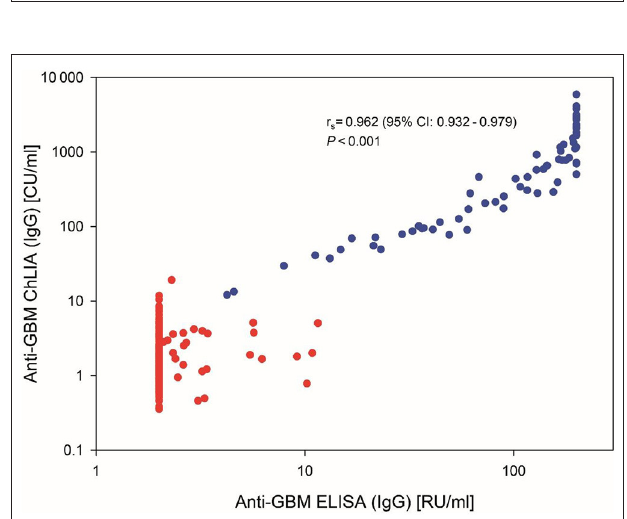
FIGURE 2 | Correlation between anti-GBM levels in 288 serum samples measured by ChLIA vs. ELISA. Axes are displayed in logarithmic scale. Anti-GBM disease samples are depicted with blue data points, control samples in red. Correlation coefficient and P -value were calculated using the Spearman’s rank